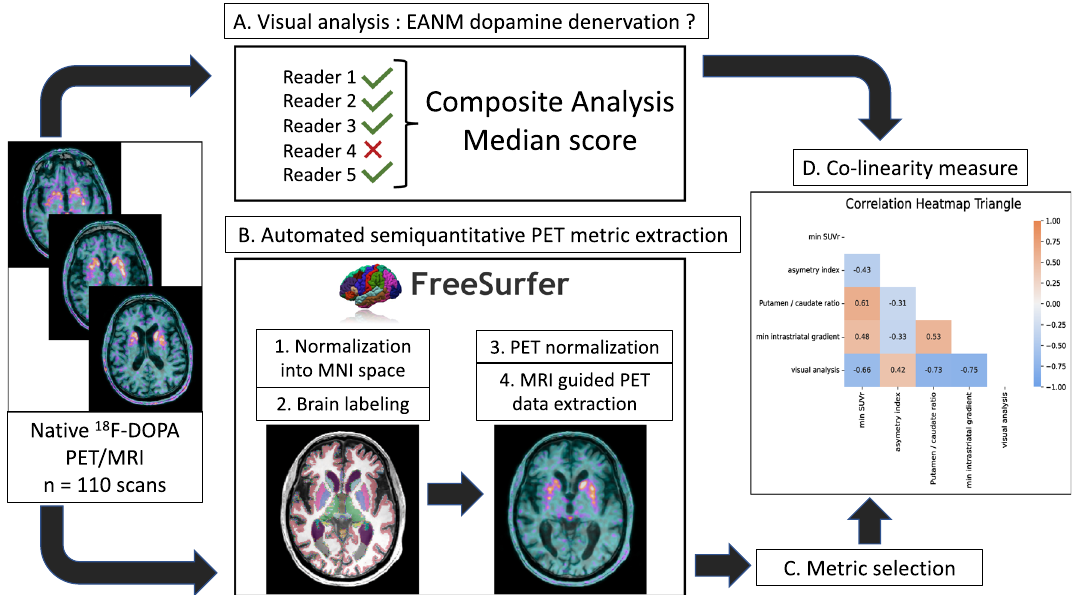
Fig. 2 Image processing and data extraction. The whole dataset was assessed both visually and automatically. For visual analysis (A), five independent readers blindly re assessed all the 18 F-DOPA PET data by using the international recommendation procedure guideline. An overall composite “visual” interpretation based on the five readers results was generated for each 18 F-DOPA PET. For automated analysis (B), the 18 F-DOPA PET/MRI data were processed in a dedicated neuroimaging pipeline (Free surfer) to be standardized and labeled. For this purpose, each T1w MRI was normalized into the MNI space, and the transformation was applied to the corresponding 18 F-DOPA PET. Numerous metrics could be extracted automatically from the standardized PET data. Finally, a subset of targeted PET metrics was retained (C) based on their conceptual relevance and explored to identify potential high collinearity